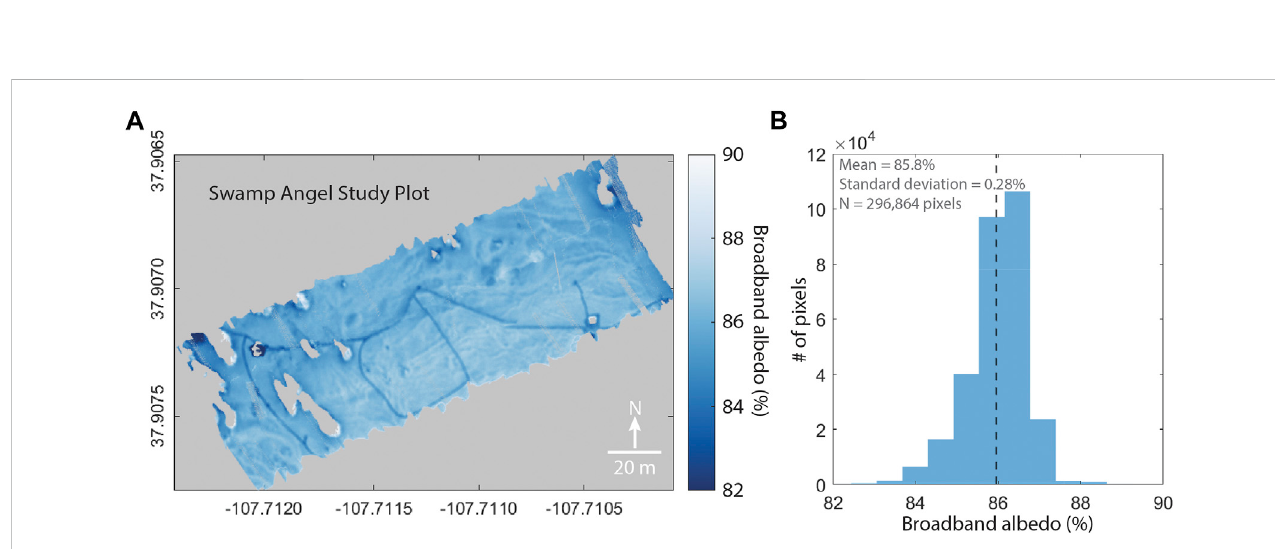
FIGURE 10 (A) Map of UAV-HSI derived broadband albedo across Swamp Angel Study Plot. (B) Histogram of broadband albedo in all pixels contained in the map from (A) .